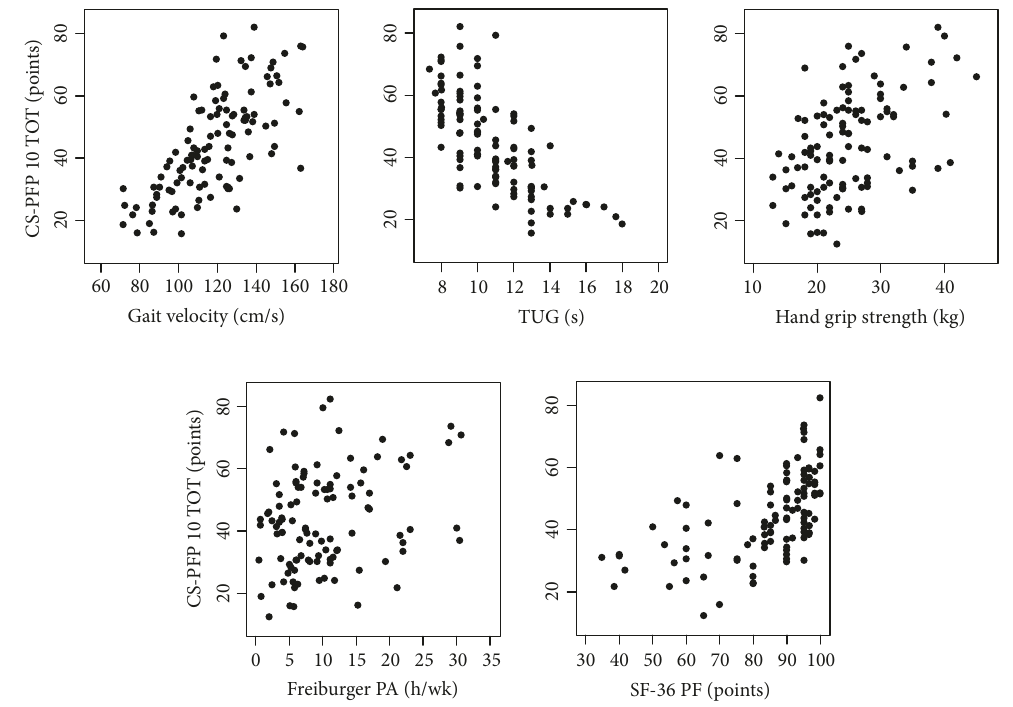
Figure 1: Scatter plots of the CS-PFP 10 total score and the concurrent validity measures.